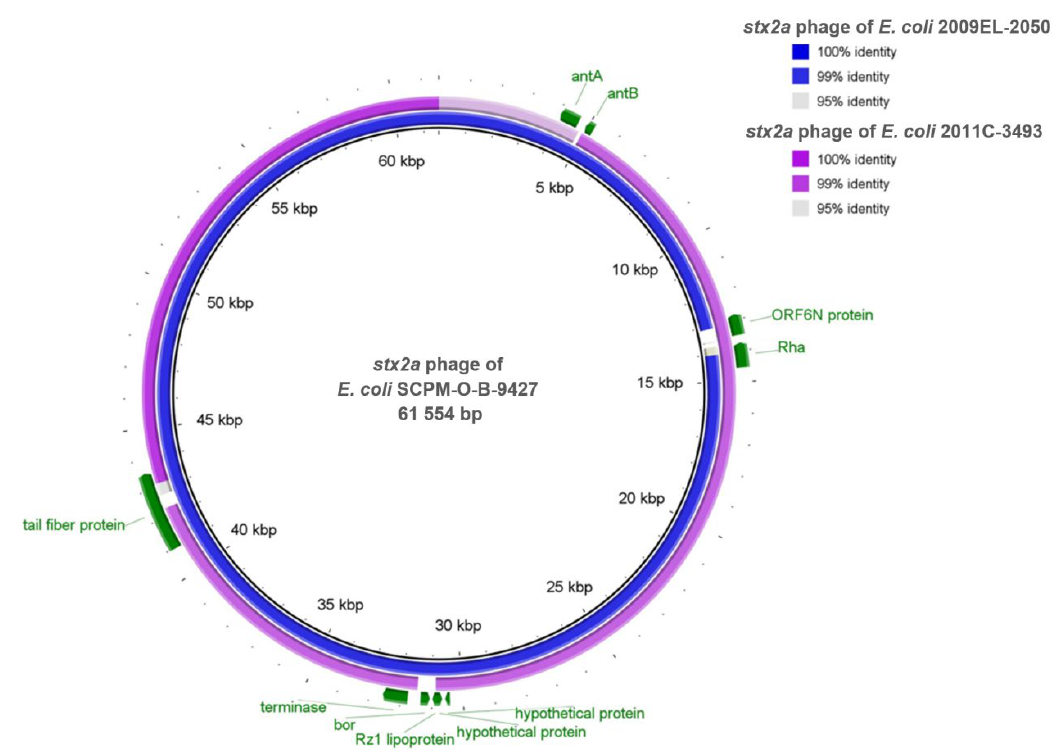
Figure 3. BRIG diagram of stx2a phages comparison. From center to outside: SCPM-O-B-9427 (black ring), 2009EL-2050 (blue ring), and 2011C-3493 (purple ring). The genes of the strain SCPM- O-B-9427 (colored green) show the regions of differences with the strains 2009EL-2050 and 2011C-